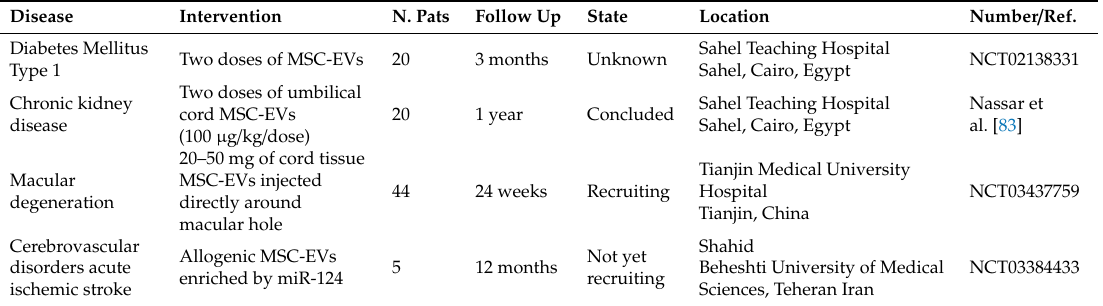
Table 2. Clinical trials using MSC-EVs for therapeutic purposes. Application, dose, number of patients, and follow-up are listed. Moreover, identification number and state of trial are